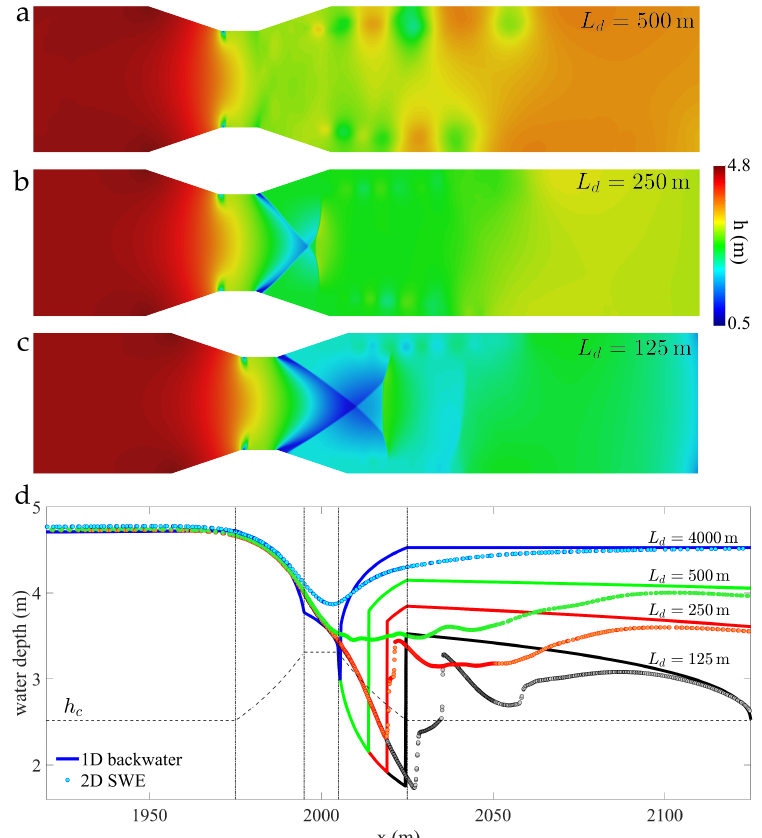
Figure 15. Onset of transcritical flow in the 1D and 2D models. By reducing the distance to the outlet, L d , we control the available energy at the downstream end of the contraction. For sufficiently small available energy, the flow is forced to undergo a regime change at the contraction. The basic model parameters are the same as those in Figures 3, 16 and 17: b 1 = 40 m, b 2 = 26.5 m, L e = 20 m, Q = 500 m 3 /s, and n = 0.04. The distance to the outlet is L d = 500 m (panel a ), L d = 250 m (panel b ), and L d = 125 m (panel c ). The 1D theory predicts an earlier onset of transcritical conditions (panel d ). In fact, it predicts that even the hydraulically-long case, L d = 4000 m is transcritical, while the 2D simulations predict near-critical conditions up to L d = 250